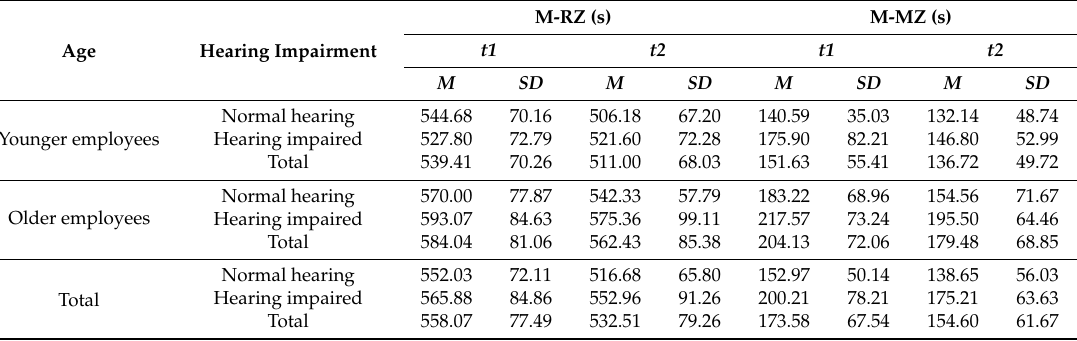
Table 3. Descriptive statistics—reaction time t1 and t2 : mean reaction time (M-RZ) and mean motor time (M-MZ).